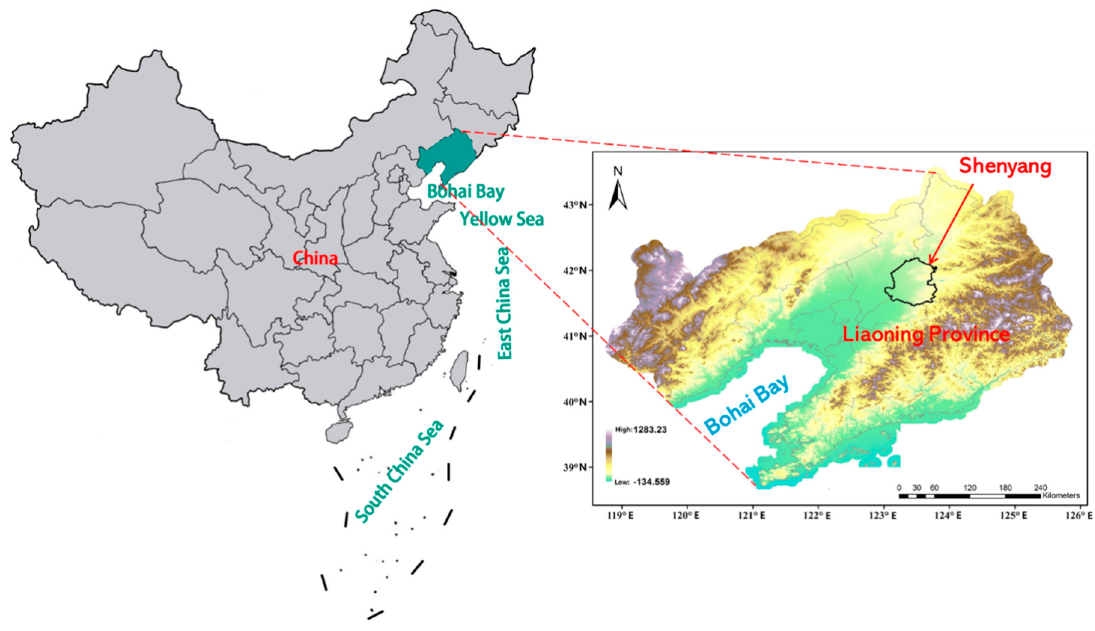
Figure 1. Location of Liaoning province, Shenyang city and the Bohai Bay.